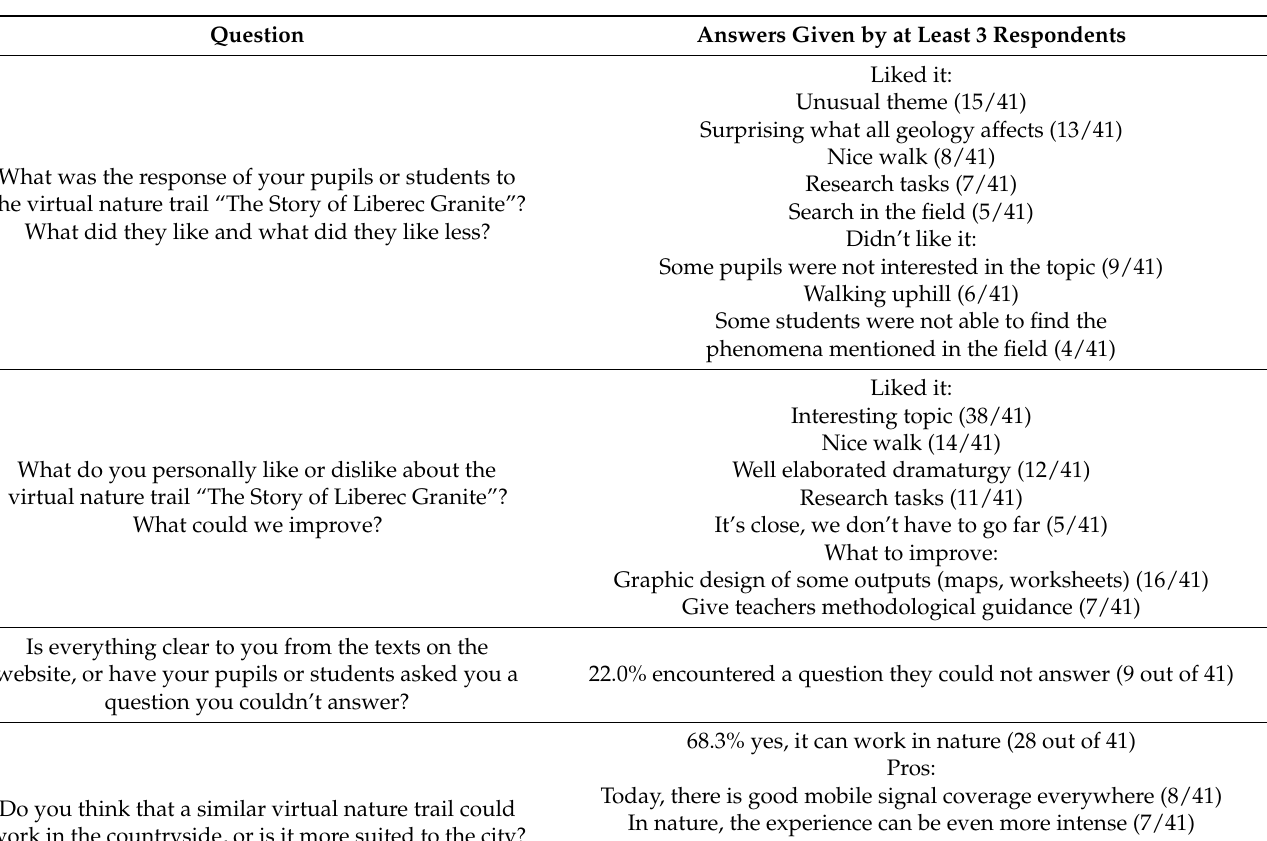
Table 2. Responses to the questions from the questionnaire concerning the evaluation of the geotrail